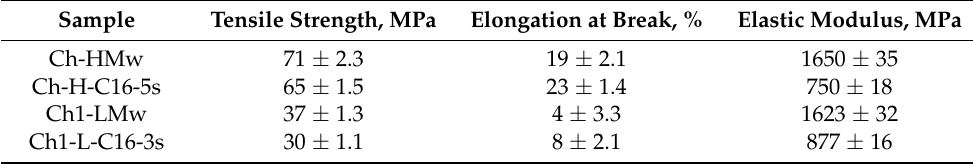
Table 4. Mechanical properties of the films of initial and the modified chitosan.